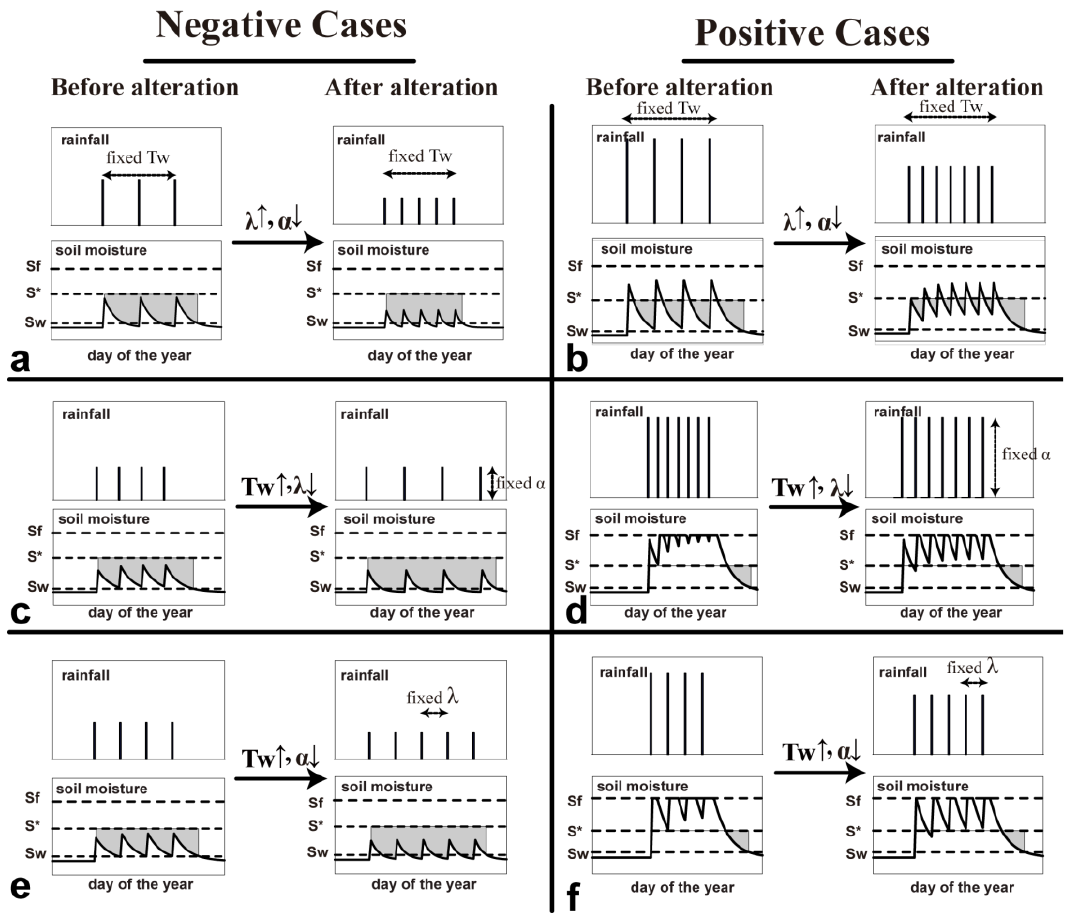
Figure 6. Illustrative time series for hydrological controls on plant root-zone soil moisture dynamics for all the experiments, and these illustrations are generalized based on the simulated time series from the experiments. Both negative and positive cases are shown, and cases with directly hydrological controls are shown (i.e. cloud-induced negative impacts in tropical forests are not shown). The cumulative shaded areas refer to “plant water stress” defined by Porporato et al. (2001).